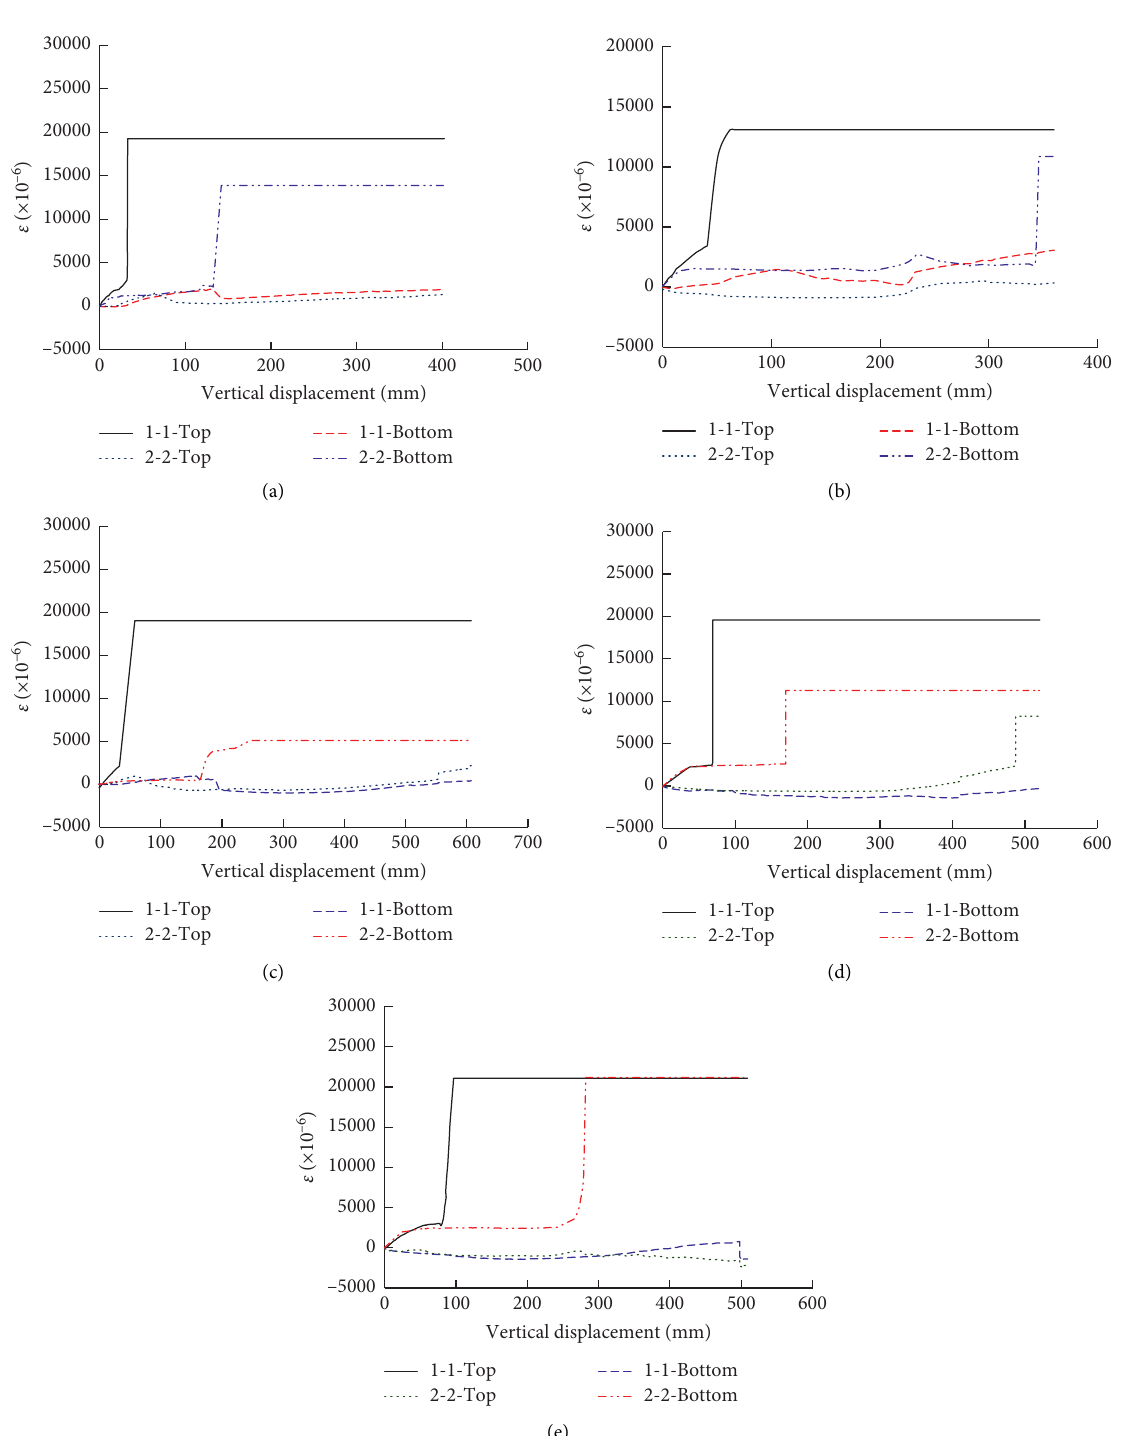
Figure 8: Strain of LRBs versus vertical displacement curves (a) S1. (b) S2. (c) S3. (d) S4. (e)